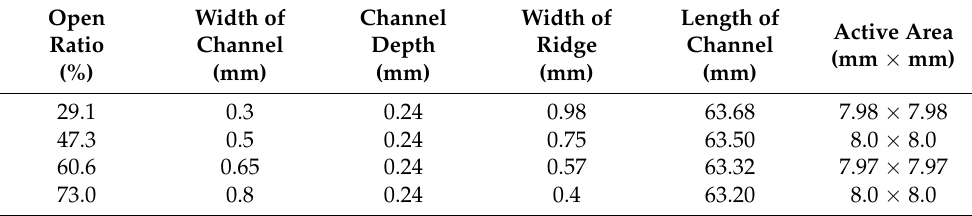
Table 2. Geometric parameters of the single-serpentine flow fields with four open ratios.